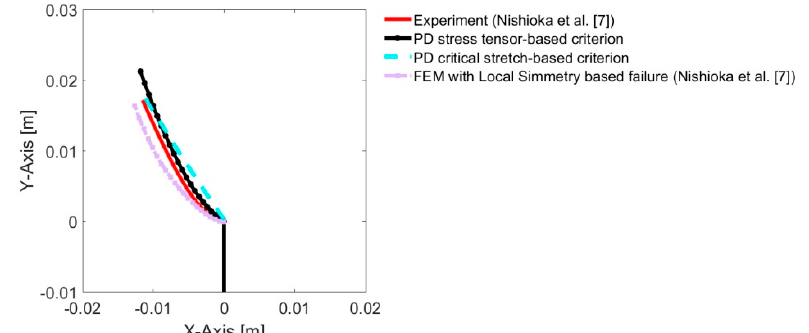
Figure 3. Comparison of the simulated crack with the experimental one and the results of other